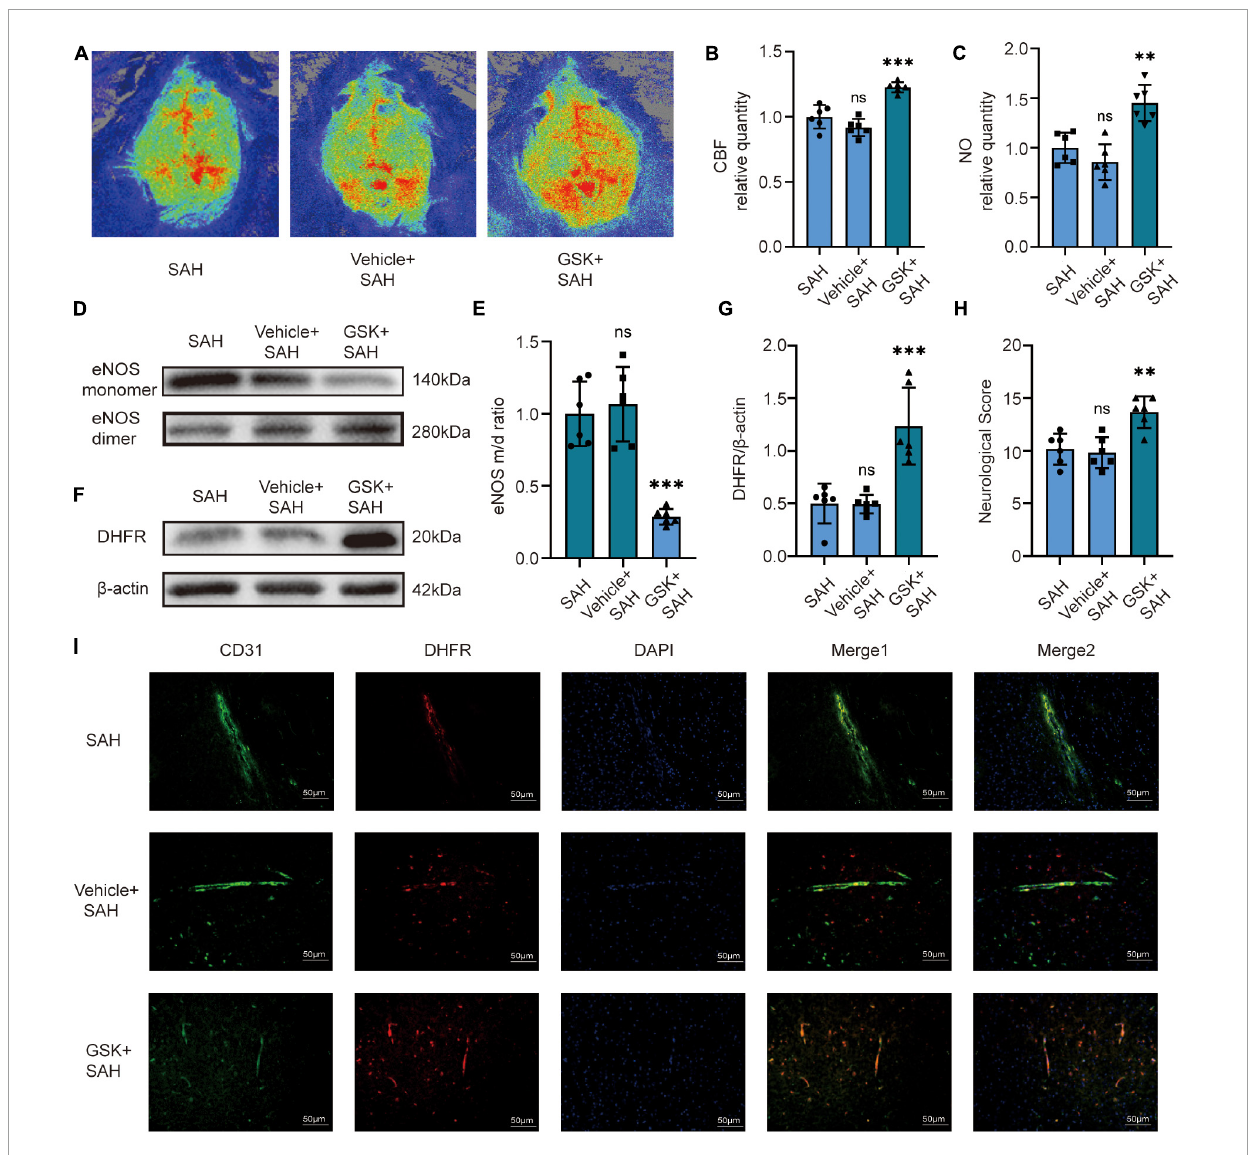
FIGURE4 In vivo , NOX2 inhibitors increased CBF in mice by recoupling eNOS after SAH. (A) Representative LSCI images among different experimental groups. (B) Quantitative analysis of CBF among different experimental groups. Data are shown as mean ± SD ( n = 6 mice each group, ∗∗∗ p < 0.001, ns, no statistically significant difference). (C) NO content in extracted endothelial cells among different experimental groups. Data are shown as mean ± SD ( n = 6 mice each group, ∗∗ p < 0.01, ns: no statistically significant difference). (D,E) Representative Western blot images and quantitative analysis of eNOS monomer and eNOS dimer expression by ImageJ. Data are shown as mean ± SD ( n = 6 mice each group, ∗∗∗ p < 0.001). (F,G) Representative Western blot images and quantitative analysis of endothelial DHFR expression by ImageJ. Data are shown as mean ± SD ( n = 6 mice each group, ∗∗∗ p < 0.001). (H) Modified Garcia Score among different experimental groups. Data are shown as mean ± SD ( n = 6 mice each group, ∗∗ p < 0.01, ns: no statistically significant difference). (I) Immunofluorescence images showed CD31 and DHFR colocalization. All scale bars, 50 µ